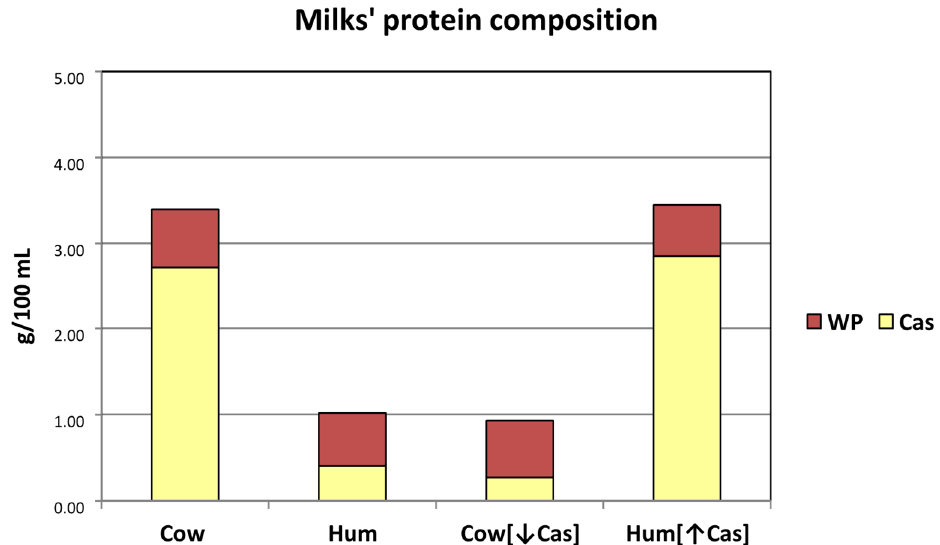
Figure 1. Schematic protein composition of the milk types employed in the study. The Y axis reports the protein concentrations (g/100 mL) of each milk type. The (approximate) casein (Cas) and whey protein (WP) concentrations are reported as either yellow (lower) or brown (upper) part of the main bars. Abbreviations: Cas: casein; Hum: human; Cow [ ↓ Cas]: low-casein cow milk; Hum [ ↑ Cas]: high- casein human milk; WP: whey protein; WP/Cas: whey protein to casein ratio.